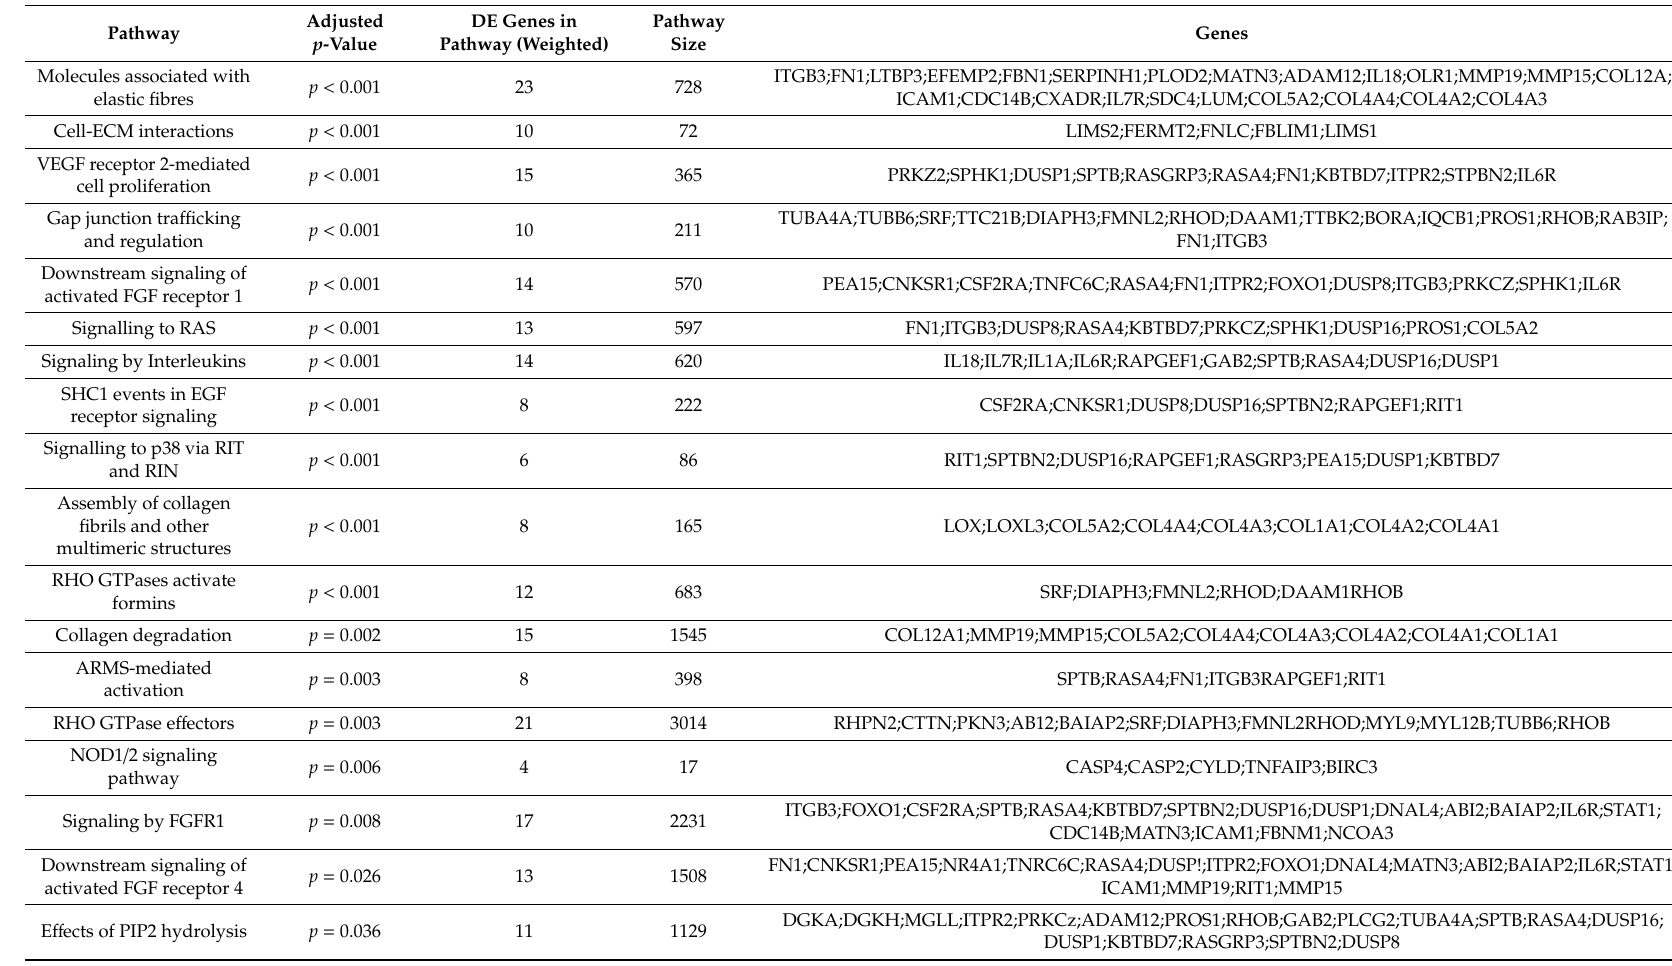
Table 1. Up-regulated pathways and genes in peptide-resistant MDA-MB-231 breast cancer